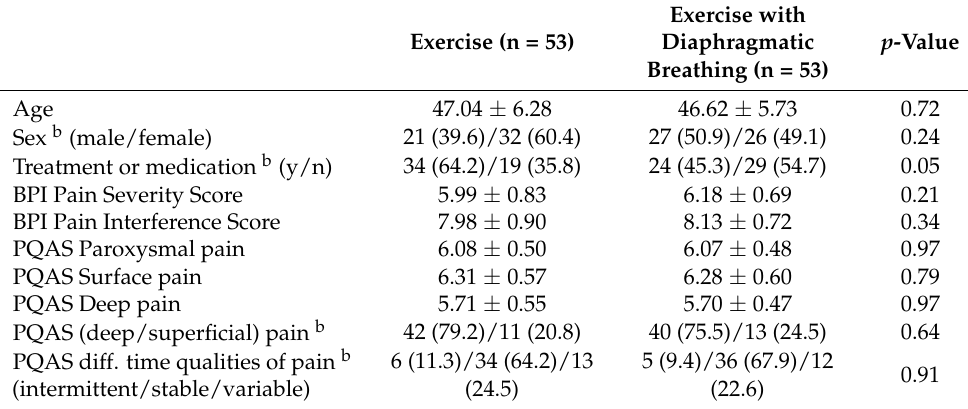
Table 2. Baseline demographic and pain characteristics between